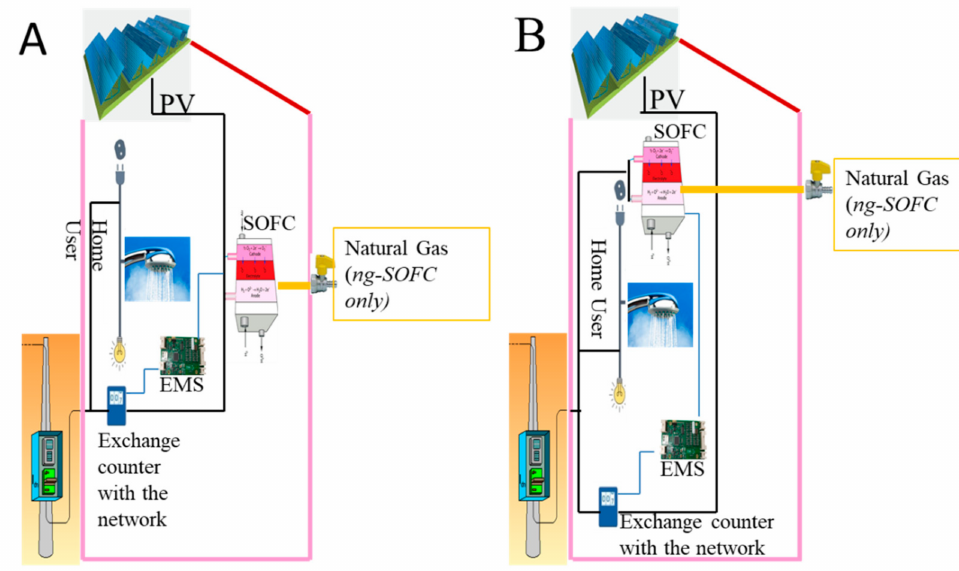
Figure 1. ( A ) Configuration with the fuel cells in front of the meter (i–iii). ( B ) Configuration installing the fuel cell behind the meter